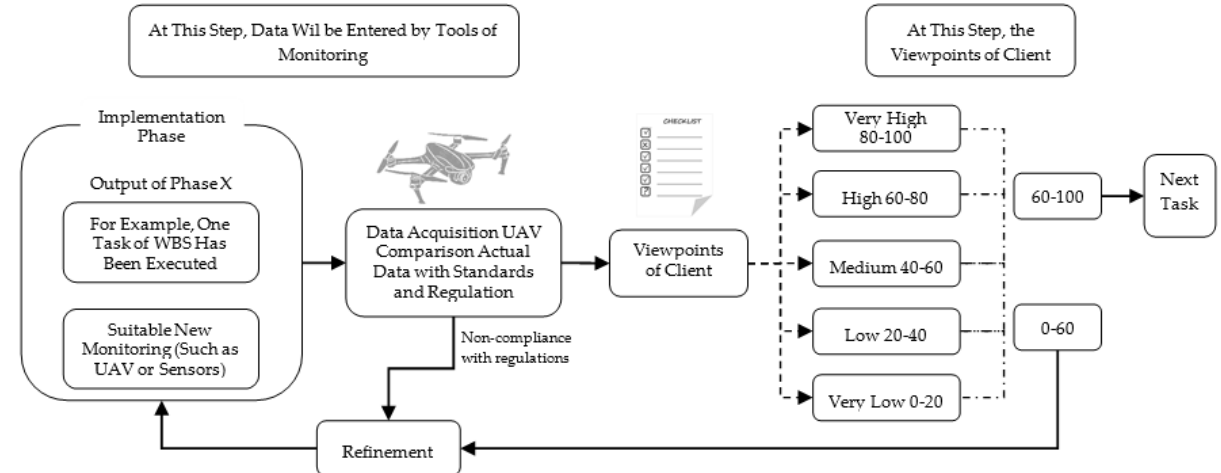
Figure 6. Flow diagram of the proposed model for the build phase of a construction project.